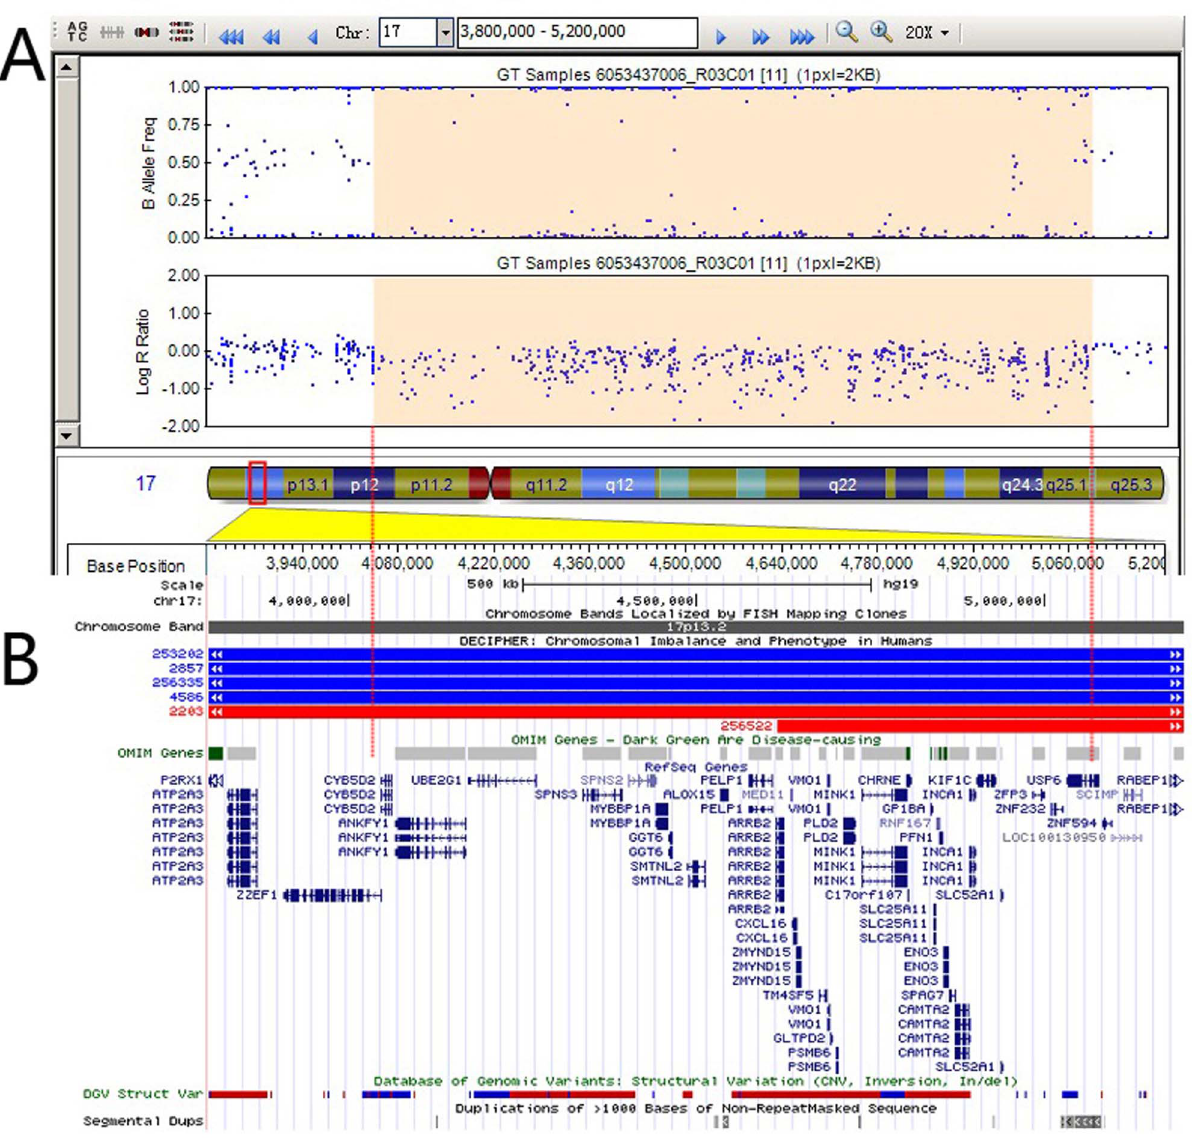
Figure 3. Illumina SNP-array result of the 17p13.2 region in patient 827979. (A) SNP based array shows a 1.05 Mb deletion at 17p13.2 (chr17:4041358-5091377) (Human GRCh37/hg19 Assembly). B allele frequency and Log R ratio are showed in the upper panel; (B) The lower panel shows genes mapped to the deleted region. OMIM genes are highlighted in green, DGV structure variants and Segmental Duplications are also enclosed in the lower